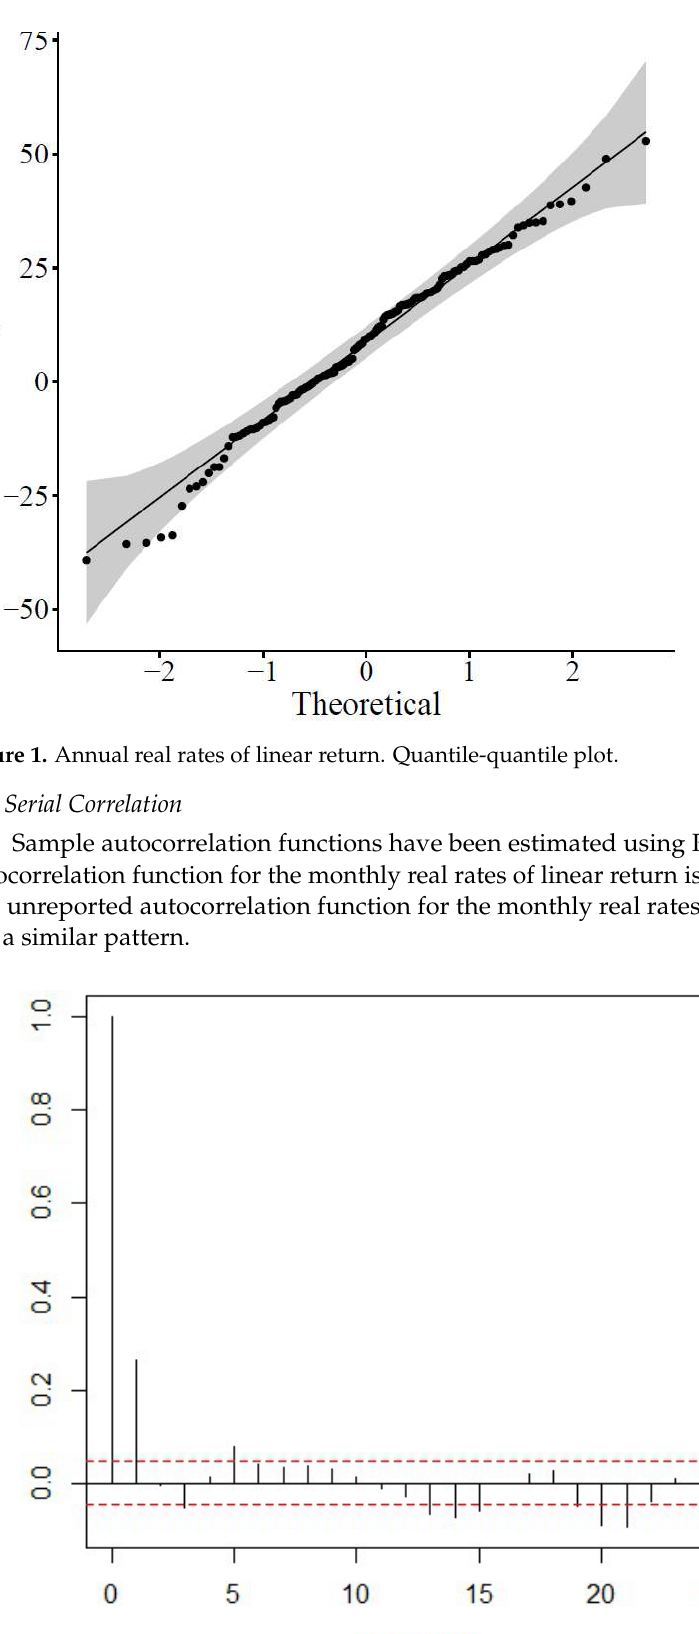
Figure 3. Annual real rates of linear return. Autocorrelation function. 4.3. Rescaled Range Analysis Use has been made of 𝑛 = 149 ∗ 12 = 1788 monthly real rates of logarithmic return from January 1872 to December 2020. The whole historical period has been divided into